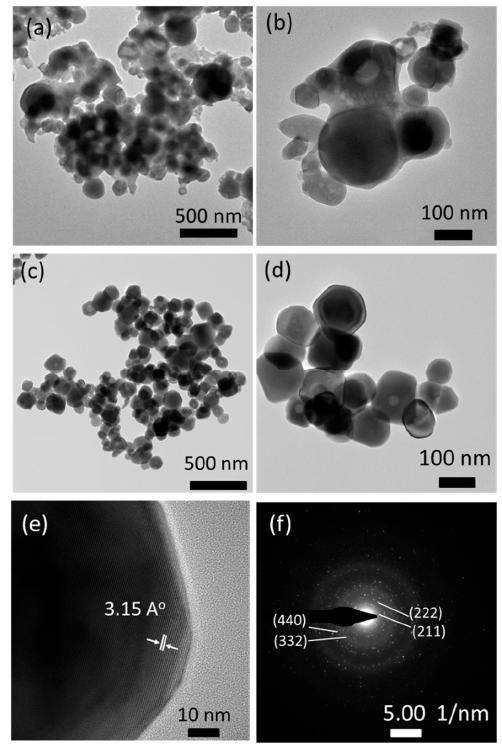
Figure 4. TEM images of FSP products prepared with sodium salts: ( a ) and (b ) as-prepared; ( c ) and ( d ) after washing with water; ( e ) high resolution image; and ( f ) selected area electron diffraction (SAED) pattern.